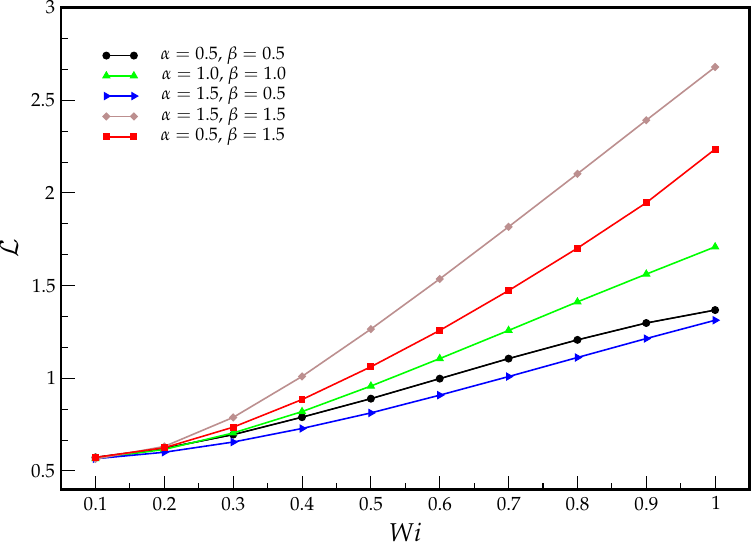
Figure 9. Development length as a function of Wi considering 98% U max ( L 98% ) and mesh M 2 . The results obtained follow the same trend observed in the case , with some L 99% minor differences. The development length is initially higher for the case α = β = 0.5 than for the case α = β = 1, until Wi = 0.2, where the growth rate of becomes larger with L 98% , the two development lengths are quite similar. Wi for α = β = 1. For L 99% For Wi = 1, we obtain a development length of 2.679 for α = β = 1.5 and a develop- ment length of 1.313 for α = 1.5, β = 0.5 (and 1.368 for α = β = 0.5). Again, these results are consistent with the idea that the higher the rate of destruction of junctions, the smaller the development length (information travels faster across the channel). Figure 10–12 show the different velocity profiles obtained at 10 different sections of the channel. The first numerical velocity profile is taken at x / H = 0.1 ( x / L = 0.01) and the last profile is taken at the middle of the channel ( x / H = 5 or x / L = 0.5).